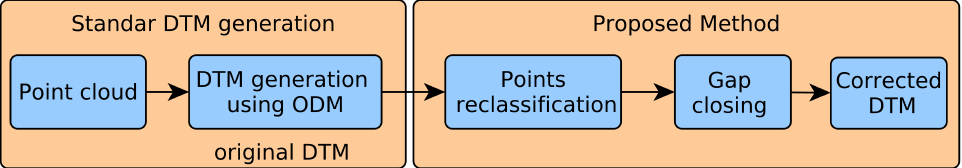
Figure 6. Workflow scheme for the digital terrain model generation using the proposed method.